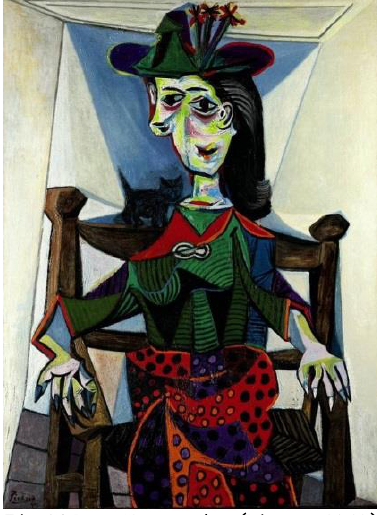
Fig. 26 Dora Mar au chat (Picasso,